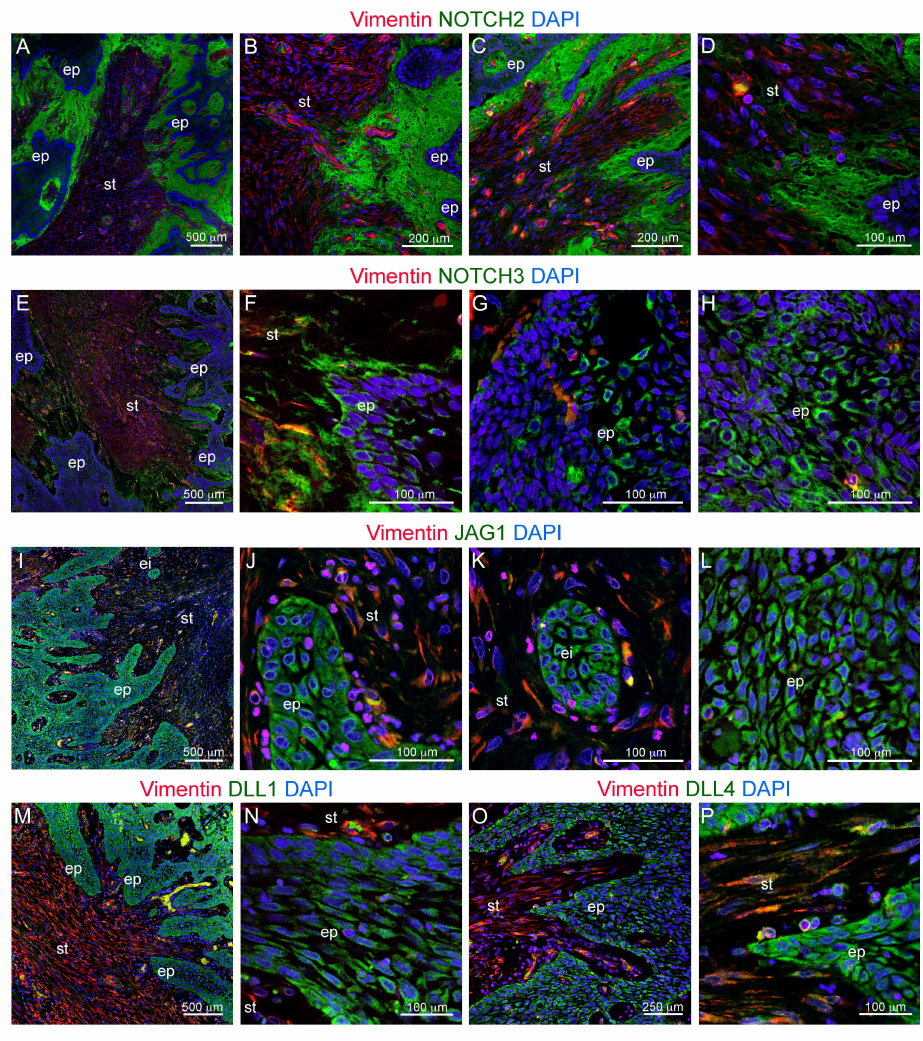
Figure 2. ( A – D ) Double immunofluorescent staining against NOTCH2 (green color) and Vimentin (red color). ( E – H ) Double immunofluorescent staining against NOTCH3 (green color) and Vimentin (red color). Blue color: DAPI. ( I – L ) Double immunofluorescent staining against JAG1 (green color) and Vimentin (red color). ( M , N ) Double immunofluorescent staining against DLL1 (green color) and Vimentin (red color). ( O , P ) Double immunofluorescent staining against DLL4 (green color) and Vimentin (red color). Blue color: DAPI. Abbreviations: ei, epithelial islet; ep, epithelium; st, stroma. Scale bars: ( A , E , I , M ): 500 µ m; ( B , C ): 200 µ m; ( D , F – H , J – L , N , P ): 100 µ m; ( O ): 250 µ